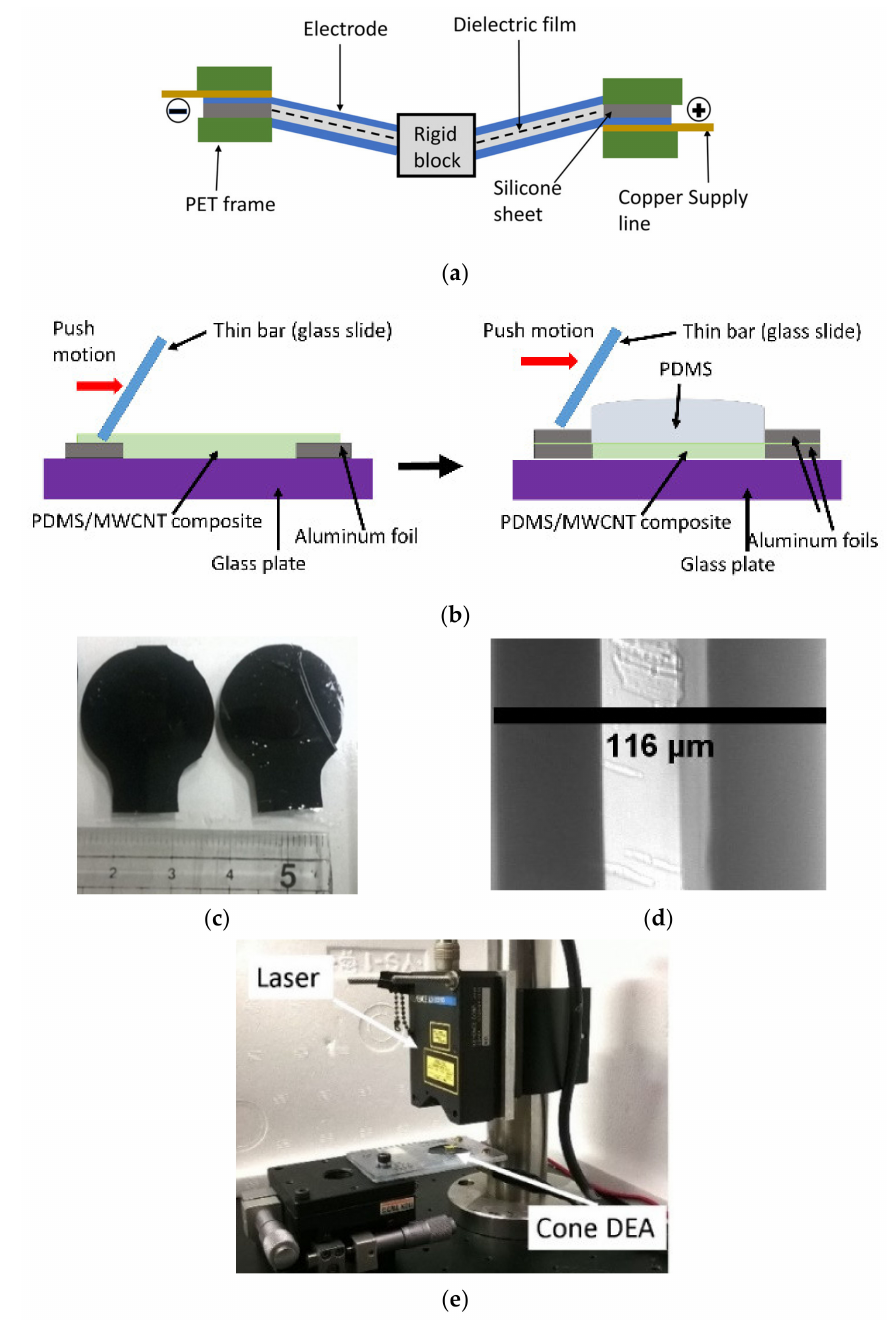
Figure 1. ( a ) Design of the cone DEA; ( b ) Fabrication of double-layer membranes consisting of a PDMS layer and a MWCNT / PDMS electrode layer by casting technique; ( c ) The membranes cut in circular shape with a protrusion for the attachment to power source; ( d ) Optical image of the cross-section of the cone DEA when the membranes of ( c ) are adjoined; ( e ) Positioning of the DEA below a laser for the measurement of the DEA vertical